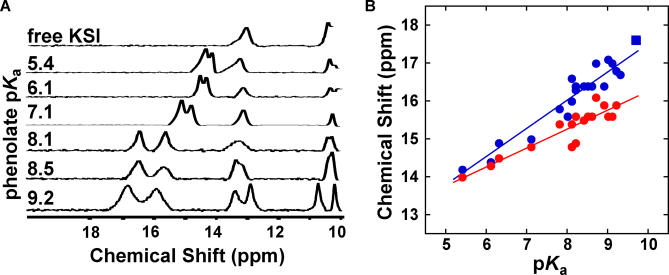

1H NMR Downfield Chemical Shifts for Substituted Phenolates Bound to tKSI
D40N
(A) Representative spectra, with phenol p
K
a shown on the left. From top to bottom: free enzyme, 3,4-dinitrophenol, 3-fluoro-4-nitrophenol, 4-nitrophenol, 3-fluoro-5-trifluoromethylphenol, 3,4-dichlorophenol, and 3-iodophenol.
(B) Correlation between increasing phenolate p
K
a and increasing chemical shift of observed downfield peaks. Circles are the two downfield peaks observed for phenolate binding. A linear fit gives slopes of 0.76 ± 0.06 and 0.50 ± 0.06 ppm/p
K
a unit for the most downfield (blue) and the second-most downfield (red) peak, respectively. The square is the main downfield peak observed with the intermediate analog equilenin (p
K
a = 9.7), for comparison.